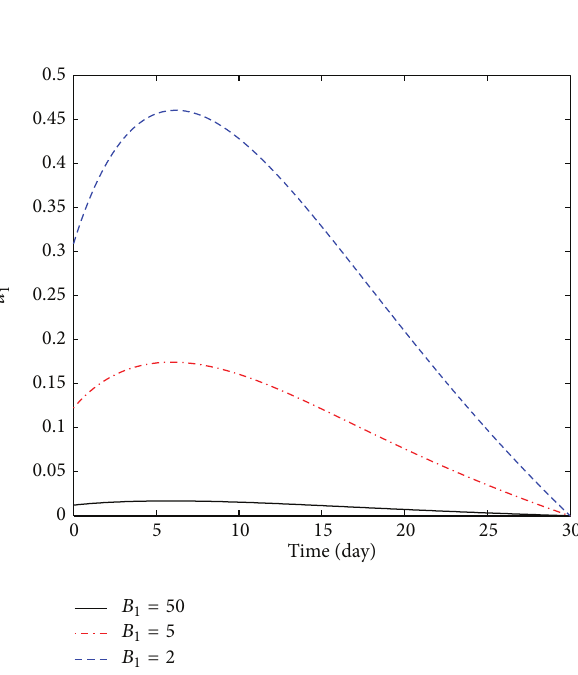
Figure 14: Plot of different weight constants on the control ( 𝐵 1 = 50 , = 5 , and 𝐵 = 2 ). 𝐵 1 1